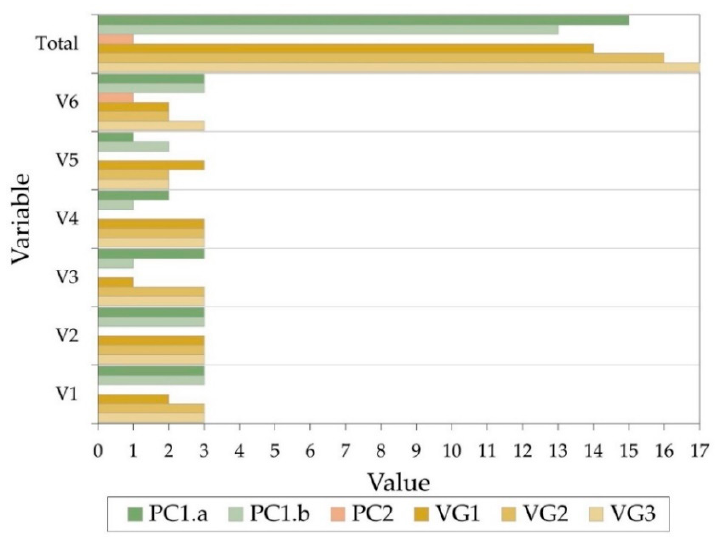
Figure 8. Performance of each section.